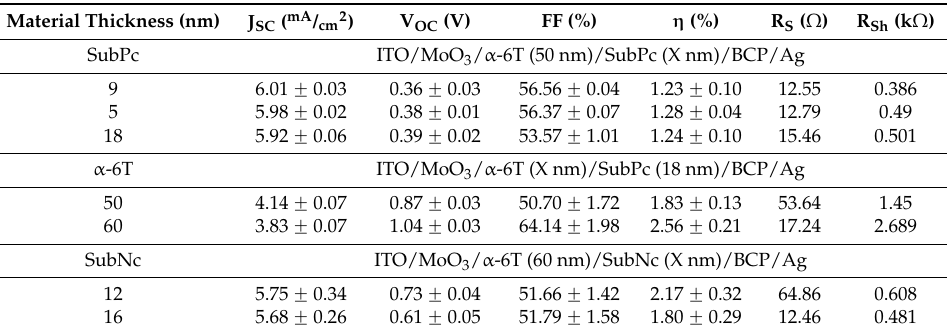
Table 3. The photovoltaic performance of bilayer OSCs ( α -6T/Acceptor) is sorted and estimated the properties of devices with MoO 3 (10 nm), BCP (10 nm), and Ag (100 nm). Material Thickness (nm)